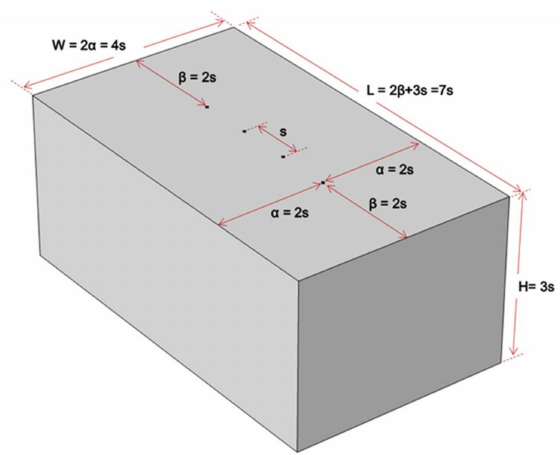
Figure 12. Schematic illustration for ER measurement